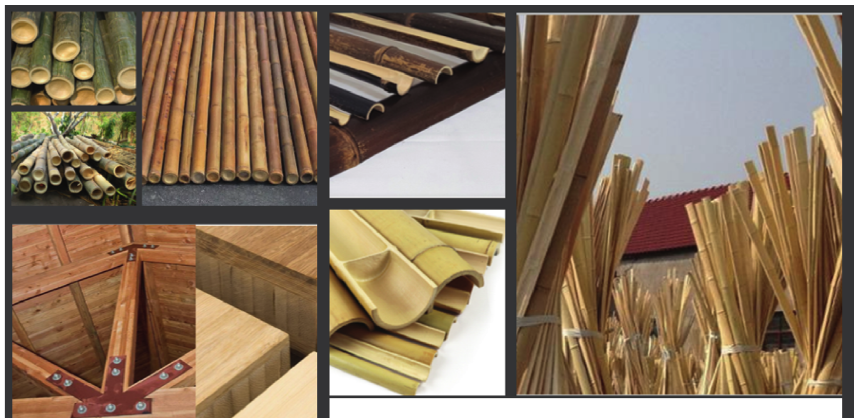
Figure 4: Round, split, glued laminated, and mechanically fastened bamboo.